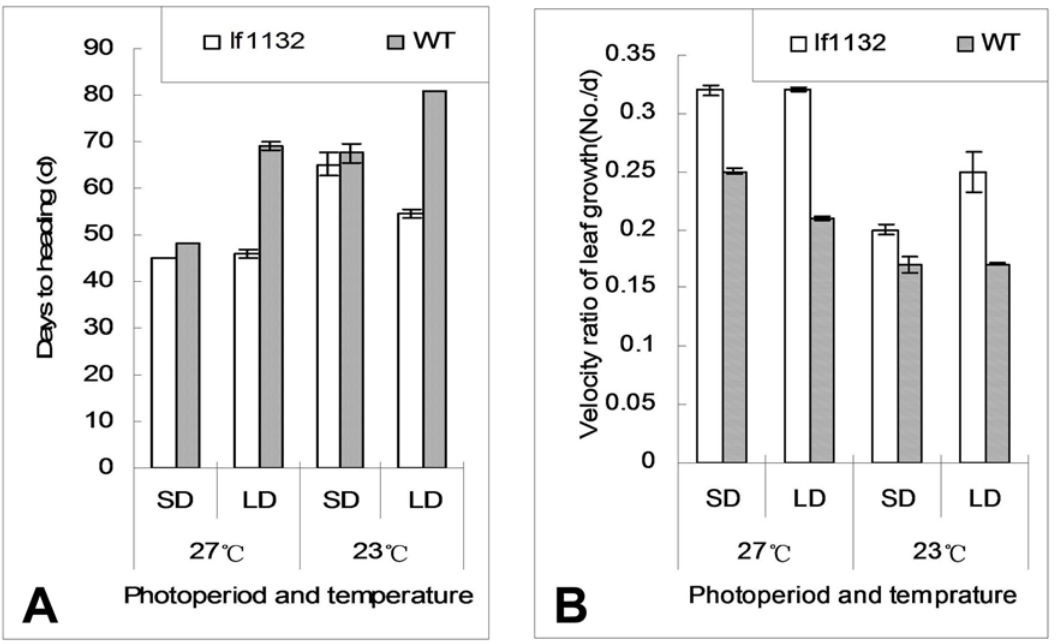
Figure 2. The heading-date of the mutant and wild type for different photoperiod and temperature treatments. lf1132 and wild type plants were planted in the CNRRI experimental fields, and two week old seedlings were transferred to phytotrons with different photoperiod and temperature treatments. The heading-date for each treatment was observed and recorded for at least 10 plants. Four phytotrons were used: LD, 27 u C phytotron; LD, 23 u C phytotron; SD, 27 u C phytotron; SD, 23 u C phytotron; A: the heading-date under different photoperiods and temperatures; B: The velocity ratio of leaf growth (VRL) for the mutant and wild type under different photoperiods (SD and LD) and temperatures (27 u C, 23 u C). LD treatment: 14.5 h light and 9.5 h dark; SD treatment: 11.5 h light and 12.5 h dark.